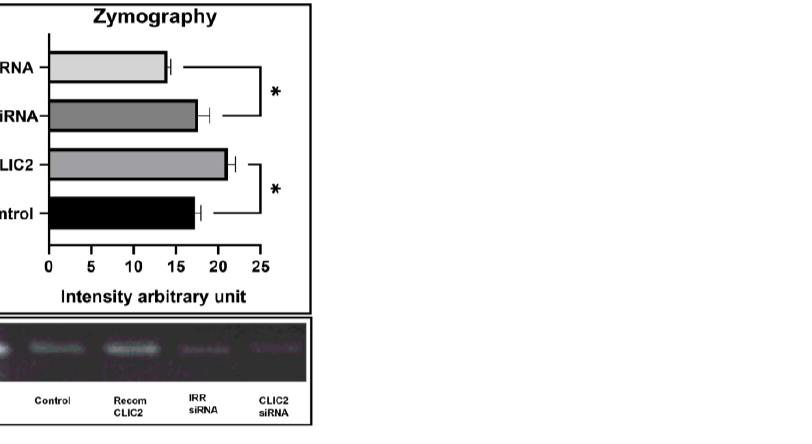
Figure 4. In microglia, CLIC2 increased the activity of MMP-9. Exposure of recombinant CLIC2 was found to increase MMP-9 activity, revealed by increased gelatinolysis in the zymographic assay using medium of primary cultured microglia, where siRNA-induced CLIC2 abolished microglia MMP-9 activity. Densitometric analysis of data ( n = 3) was presented as mean ± SD and analyzed with unpaired two-tailed t -test. * p < 0.05 indicates significant differences between the two groups ( A ). Representative image data ( B ).